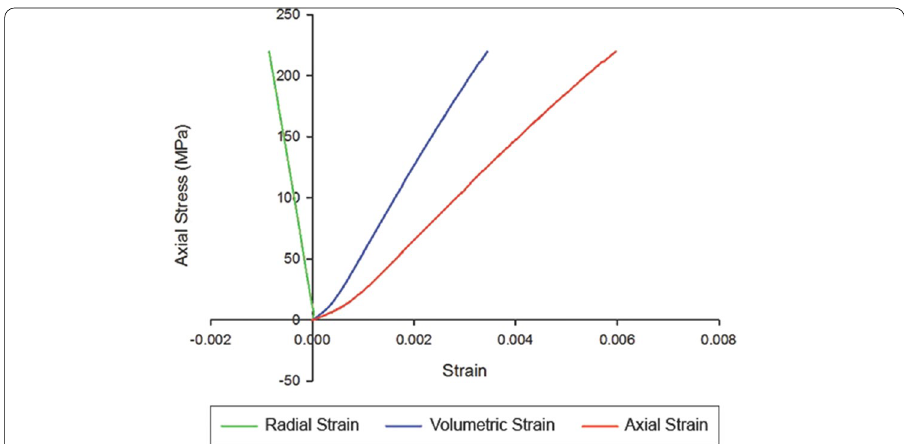
Fig. 4 Stress–strain curves obtained from the uniaxial test of the Waipapa greywacke sample TTGW_11_2_2. These results are typical of the UCS tests in general